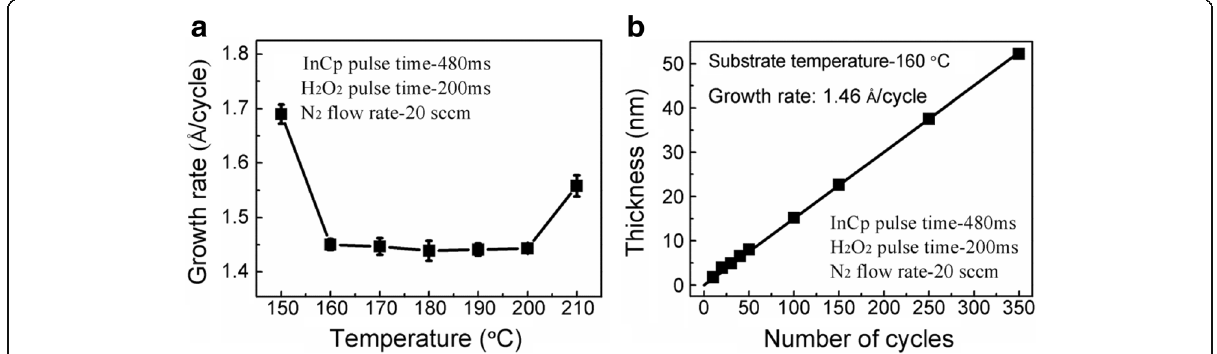
Fig. 1 a Growth rate of ALD In 2 O 3 film on the Si substrate as a function of substrate temperature, and b dependence of the In 2 O 3 film thickness on the number of ALD cycles at 160